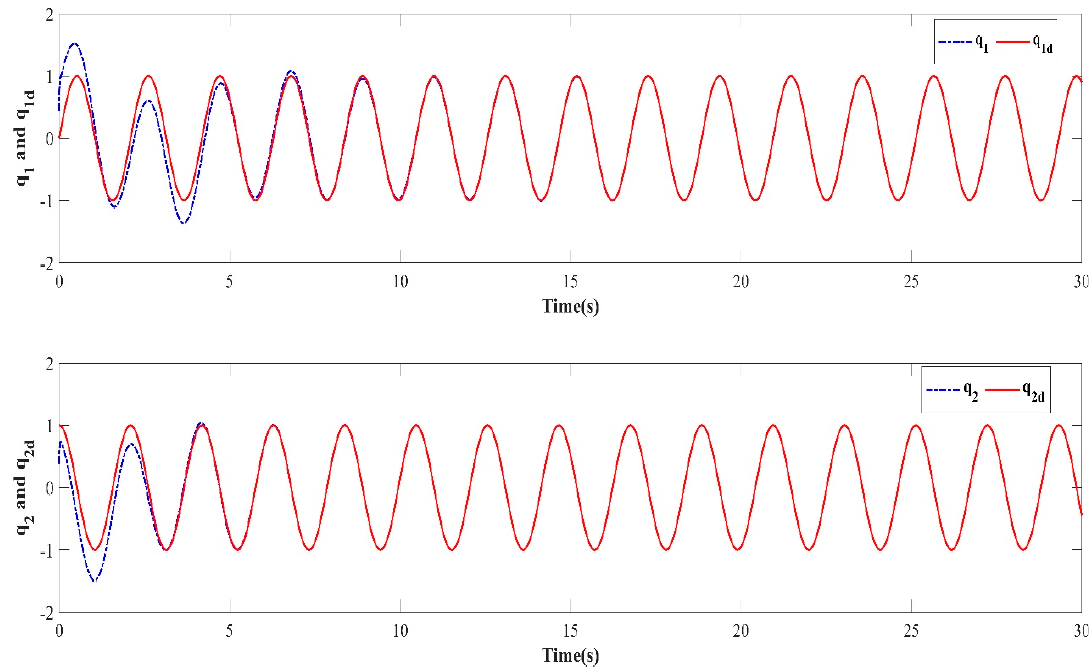
Figure 7. Learning trajectory in the tenth iteration.